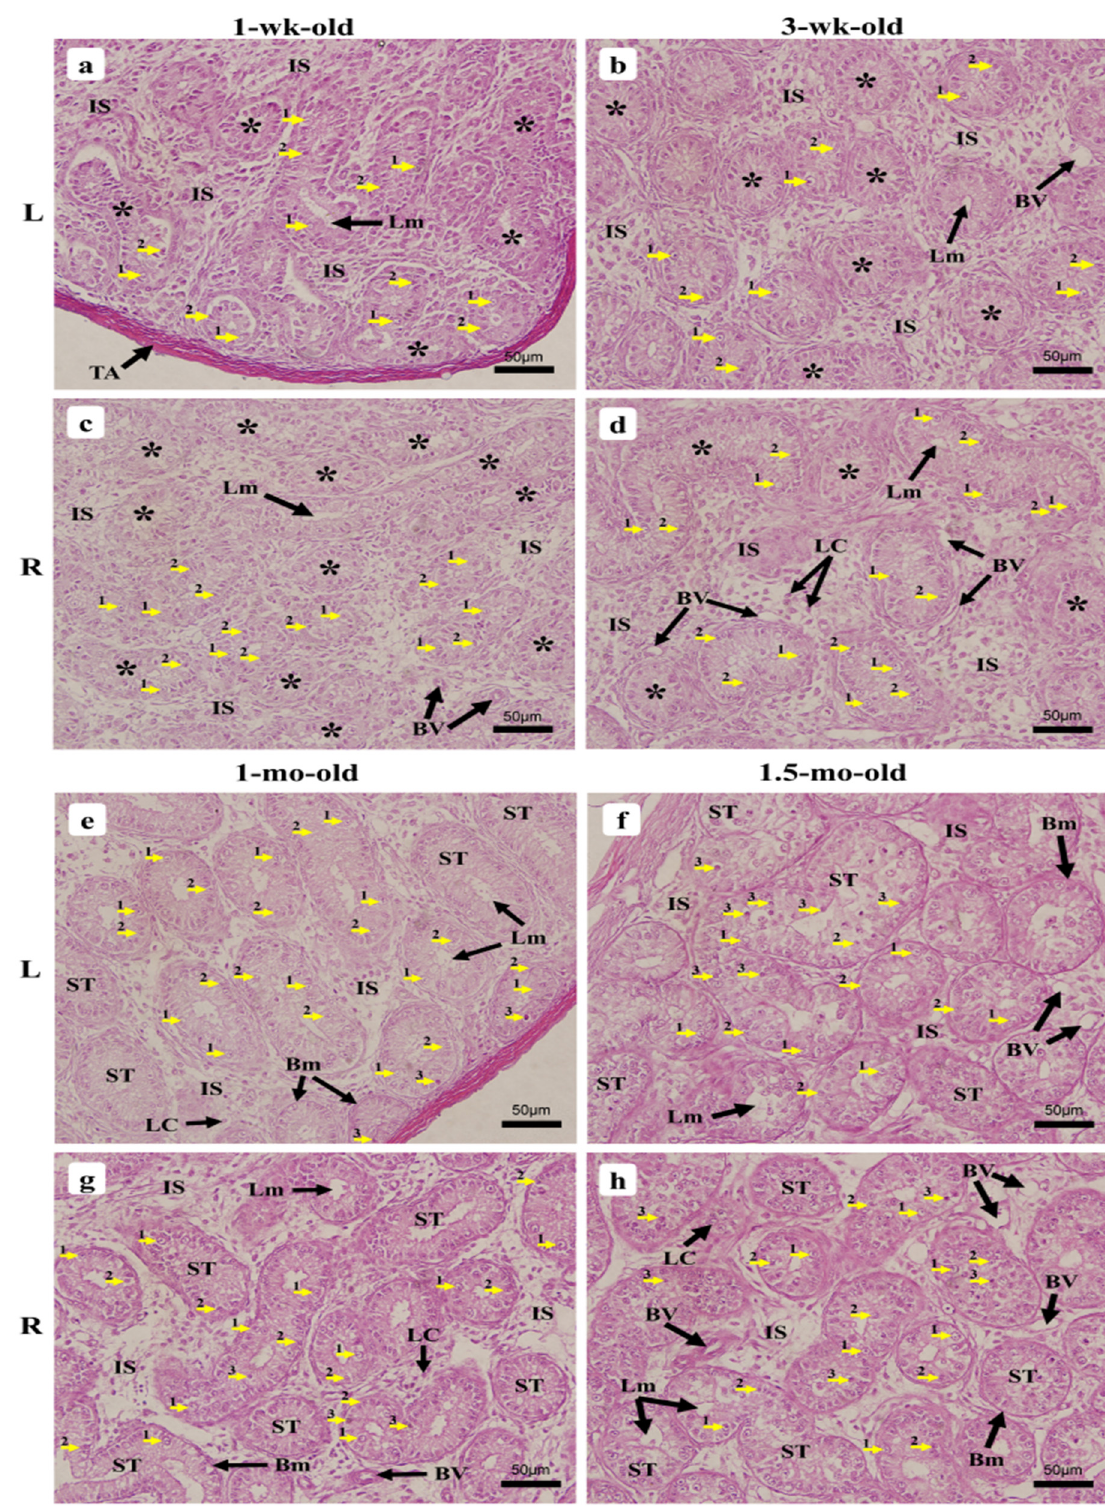
Figure 6. Seminiferous tubules’ morphometry for the growing chickens (Mean ± SD). ( A ) Tubule diameters; ( B ) tubule’s epithelium thickness; ( C ) lumen diameters. Statistical difference: ** p < 0.01; * p < 0.05; independent samples T tested for significance. Marked differences labeled by dif- ferent superscript lowercase letters ( p < 0.05); different capital letters of superscript indicate an ex- tremely significant difference ( p < 0.01). One-way ANOVA test for significance; Duncan for multiple comparisons.